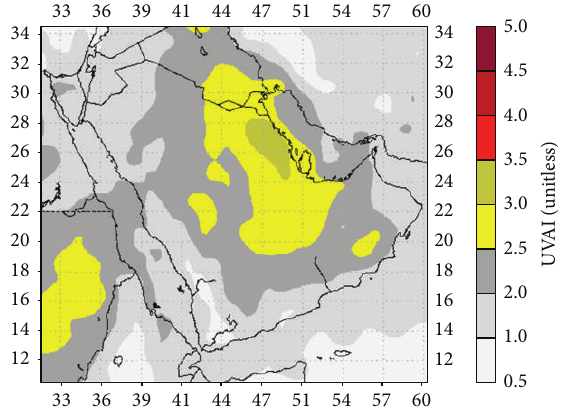
Figure 9: OMI UVAI image over Saudi Arabia on March 09, 2009.